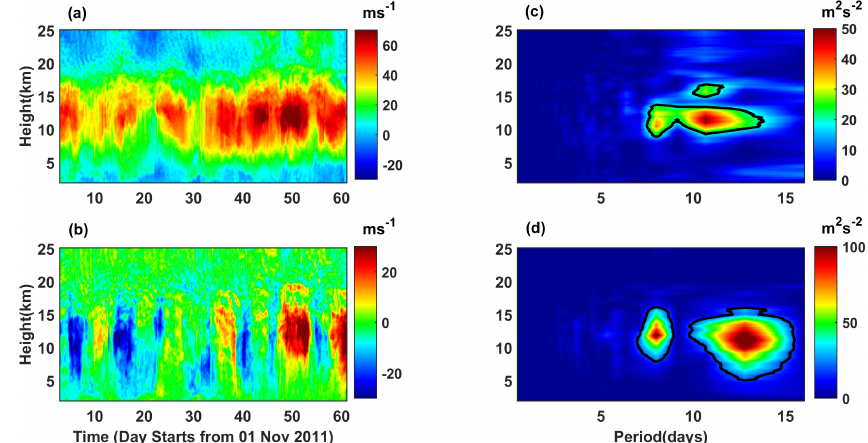
Figure 1. Zonal (a) and meridional (b) wind velocities measured by the radiosondes launched at 6-hourly intervals from an extratropical site at ARIES, Nainital (29.45 ◦ N, 79.5 ◦ E), between 1 November and 31 December 2011. The corresponding Fourier spectral amplitudes (m 2 s − 2 ) of zonal and meridional perturbations are shown in (c) and (d) , respectively. The contours in (c) and (d) are significant at a 90% confidence